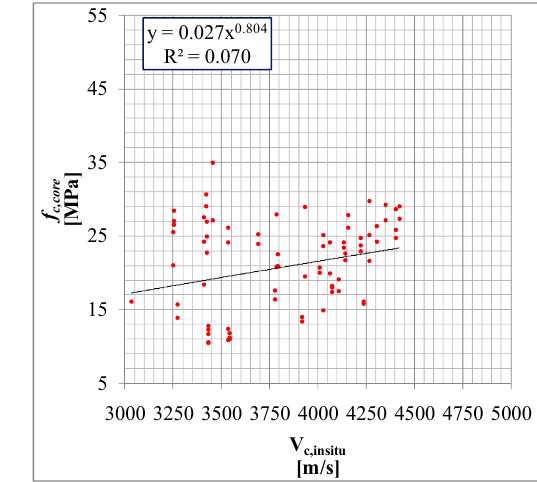
Figure 12. Comparisonof direct ultrasonic velocity samples vs. compressive concrete strength ( a ) and in situ ultrasonic velocity vs. compressive concrete strength ( b ).